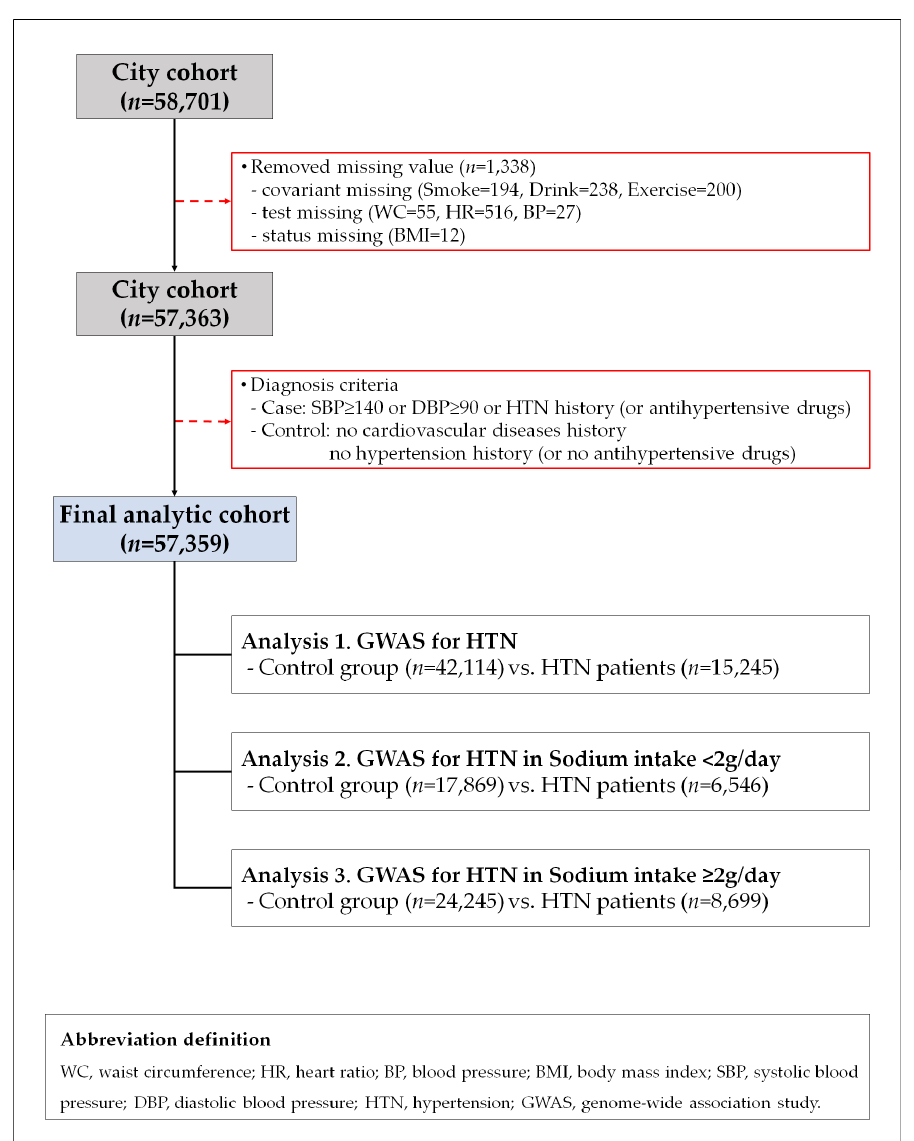
Figure 1. Flow chart of study population.